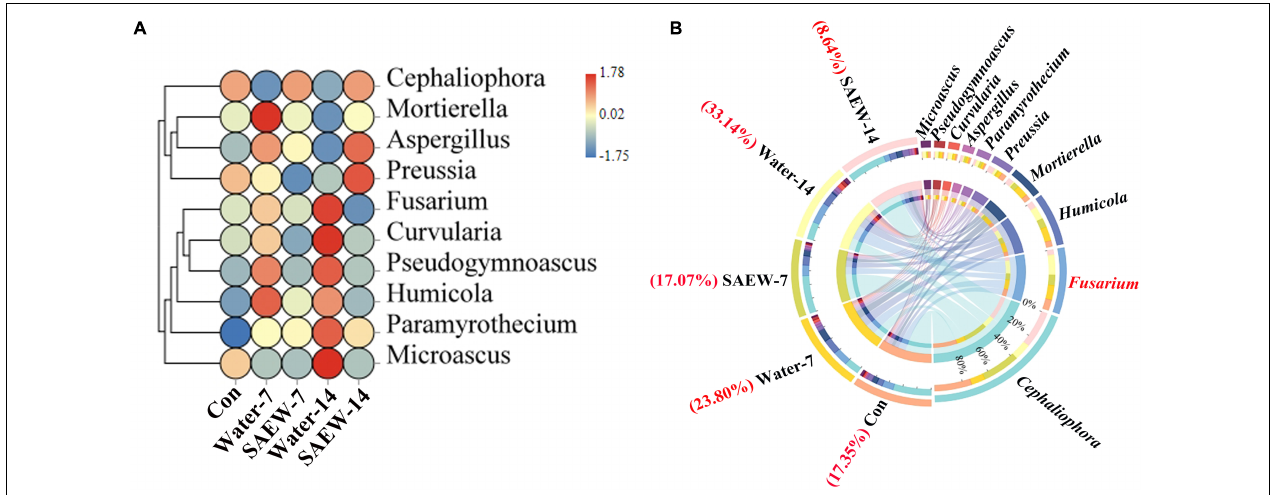
FIGURE 3 | Heatmap and Circos analyses of the key fungal species that were significantly affected by slightly acidic electrolyzed water (SAEW). (A) shows the heatmap of species distribution at the genus level according to OTUs, and (B) shows the ratios of the main fungal species to the fungal amount. The more red, the higher abundance of species, and the more blue, the lower abundance of species in panel (A) . The red font of panel (B) represents the ratio of Fusarium of different treatments. The soils with different treatments (Con, Water-7, Water-14, SAEW-7, and SAEW-14) were separately collected from 5 replicated pots for each. Con and control (dry soil); Water-7 (the soil irrigated with deionized water for 7 days); Water-14 (the soil irrigated with deionized water for 14 days); SAEW-7 (the soil irrigated with 60 ppm concentration of slightly acidic electrolyzed water for 7 days); SAEW-14 (the soil irrigated with 60 ppm concentration of slightly acidic electrolyzed water for 14